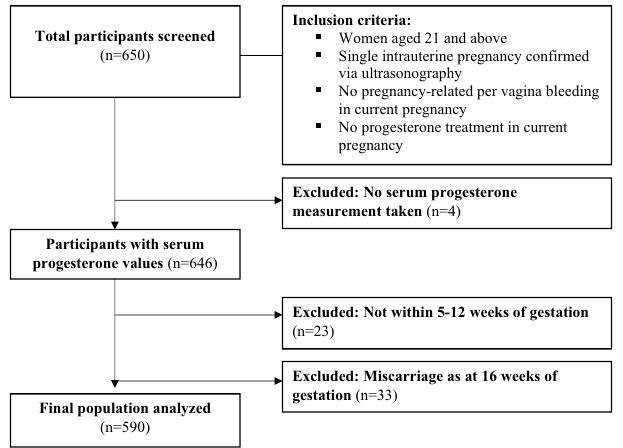
Figure 1. Consort diagram of study participants used to establish normative values of serum progesterone.